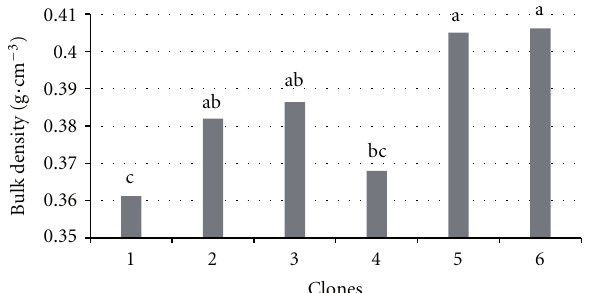
Figure 4: Mean values of charcoal bulk density of Eucalyptus spp., in g · cm − 3 . Standard deviation = 0.02; variation coe ffi cient = 3.6%. Means followed by same letter do not di ff er at 5% probability by Tukey